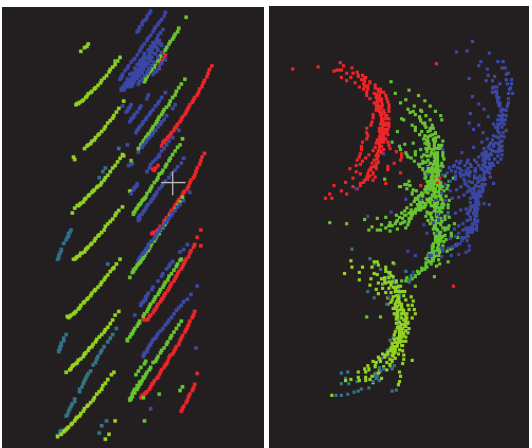
Figure 9. The significant planimetric misalignment (left image) was absent after registration and transformation (right image). UAV data is in white colour whereas other colours belong to BLS data.